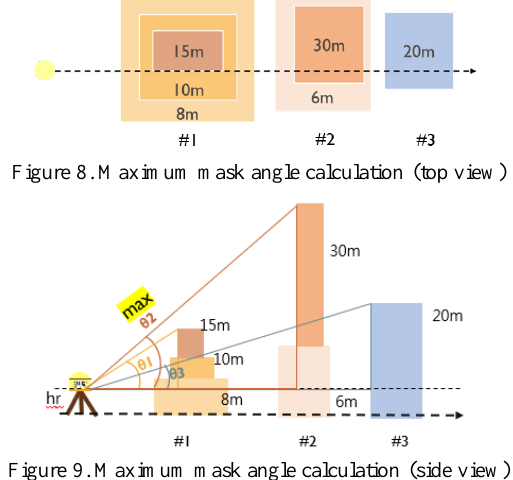
Figure 9. Maximum mask angle calculation (side view)